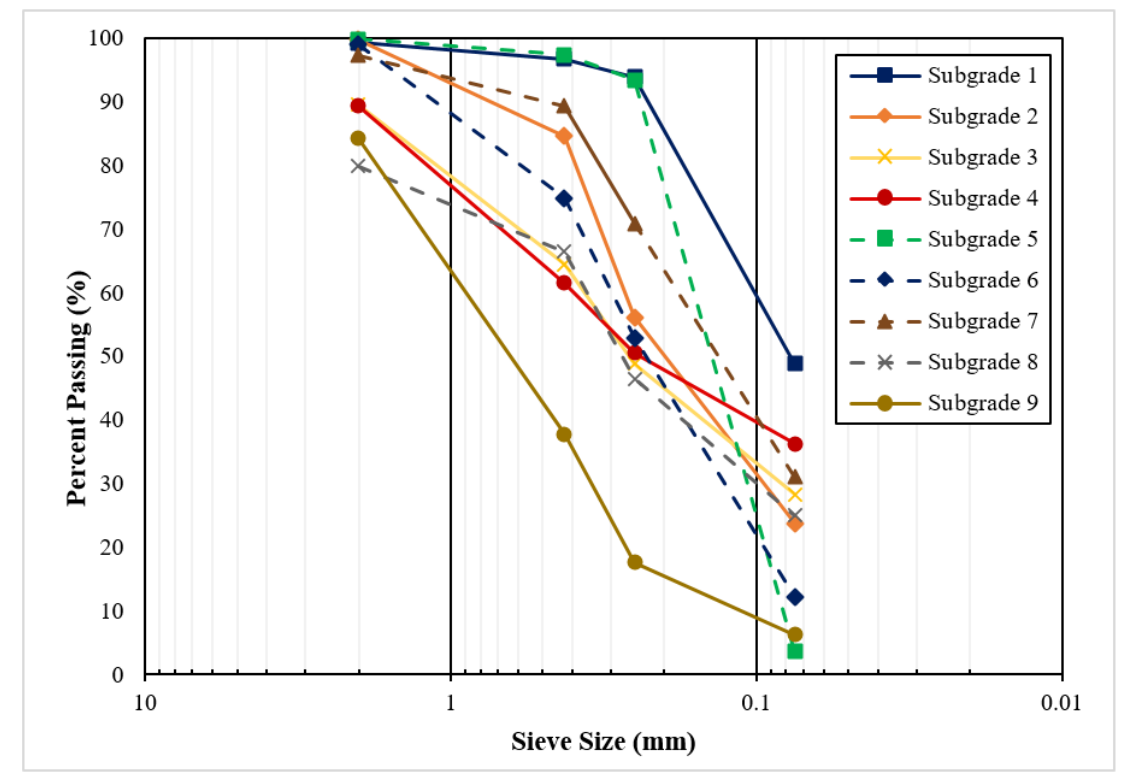
Figure 2. Subgrade gradation [4].